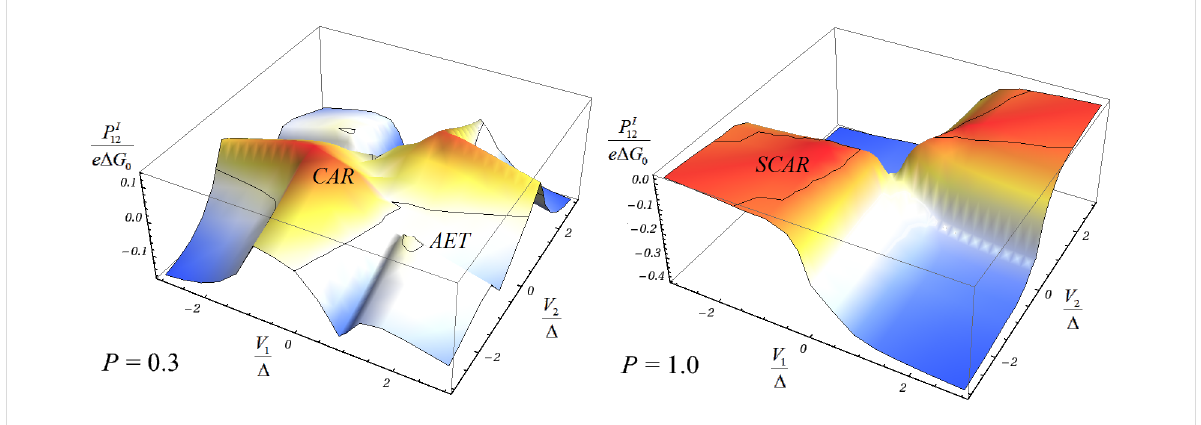
Figure 2: Cross correlation of currents for different parameters: The cross correlation according to Equation 13 is calculated for two different sets of parameters. The polarization of the ferromagnets is assumed to be equal in both cases. The left graph shows the result for P = 0.3, Γ S = 4 Δ , Γ SF = 0, Γ F 1 = 0.4 Δ , Γ F 2 = 0.1 Δ and T = 0.1 Δ . The right graph is for P = 1, Γ S = 2 Δ , Γ SF = Δ , Γ F 1 = 0.05 Δ = Γ F 2 and T = 0.1 Δ . A distortion of the super- conducting DOS described by a Dynes parameter [72] of Γ D = 0.005 Δ has been introduced in order to circumvent numerical artifacts of the diverging superconductor DOS. The cross correlations are positive in the deep-red